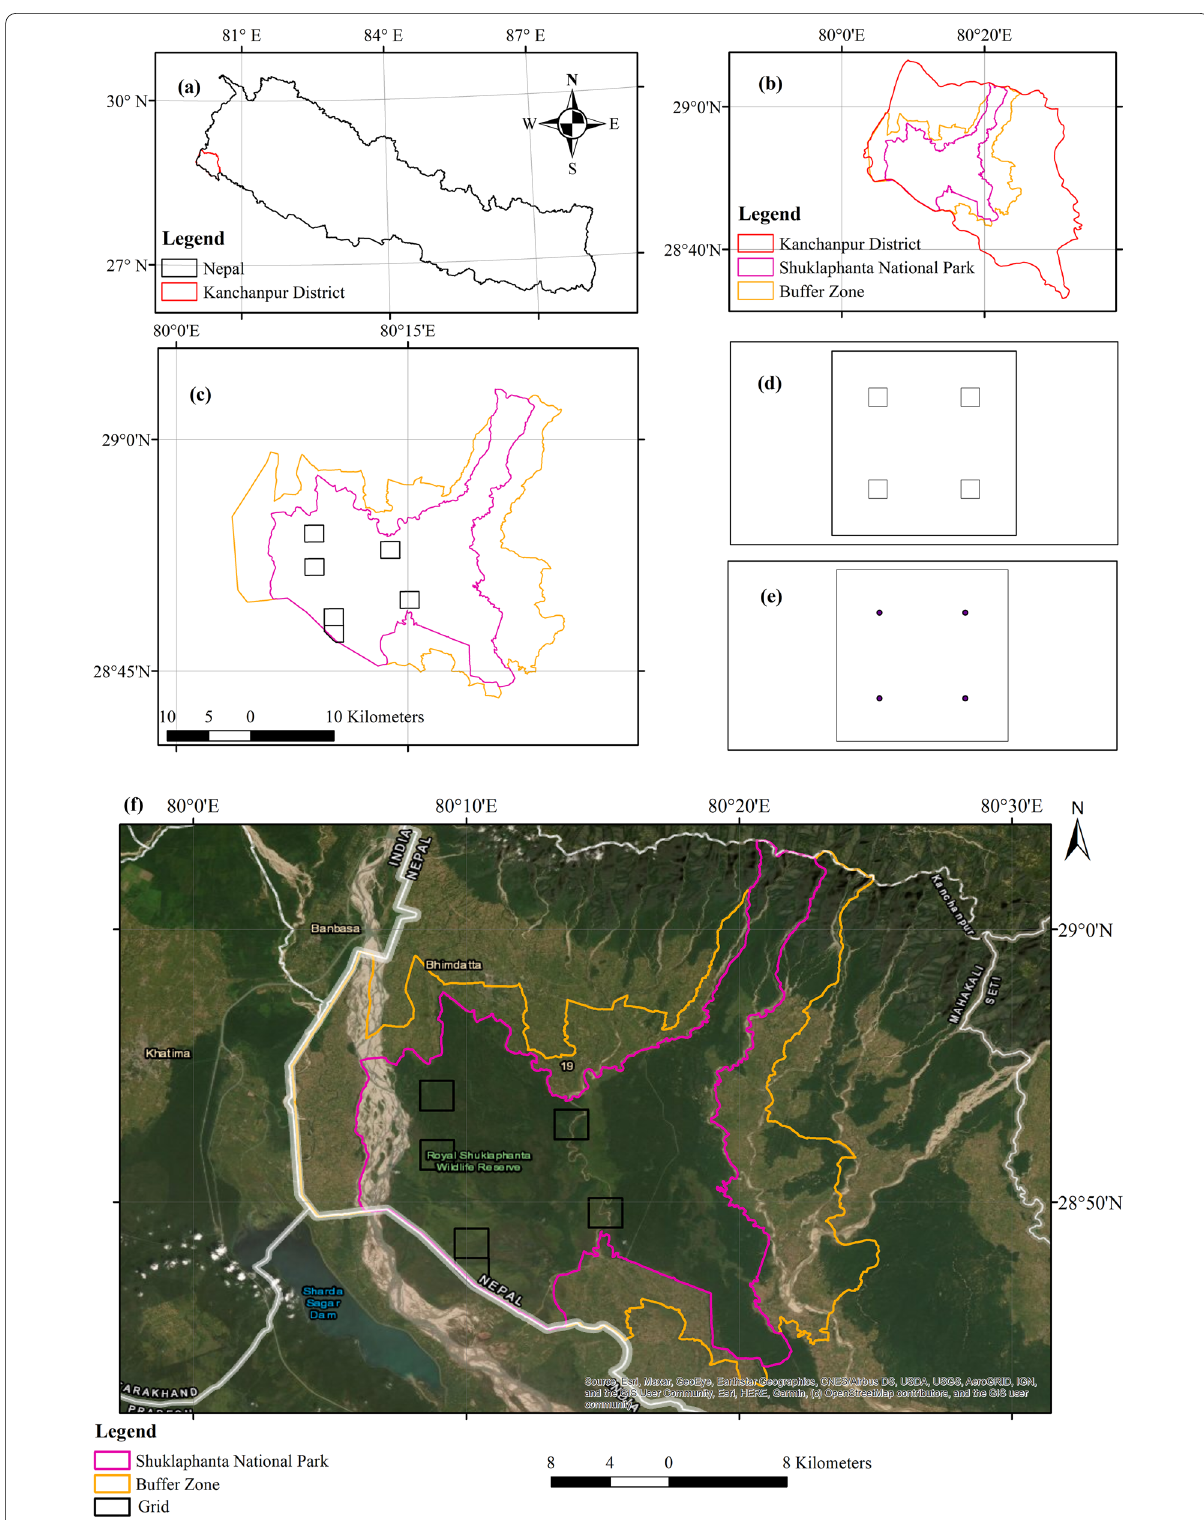
Fig. 2 Study design a map showing Kanchanpur district in Nepal, b Shuklaphanta National Park core area and buffer zone in Kanchanpur district, c Grids ( ▢ ) of 2 km 2 km inside the Shuklaphanta National Park, d sub-grids of 200 m × inside sub-grid, f Study design with base map extracted from the Google